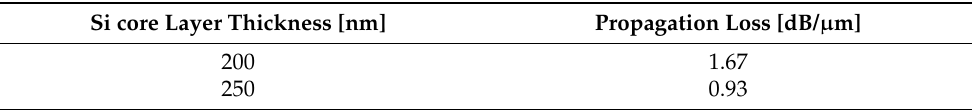
Table 2. Calculated propagation loss with Si core layer thicknesses of 200 and 250 nm, for fixed SiO 2 buffer layer thickness of 100 nm, Co layer thickness of 200 nm, and wavelength of 1550